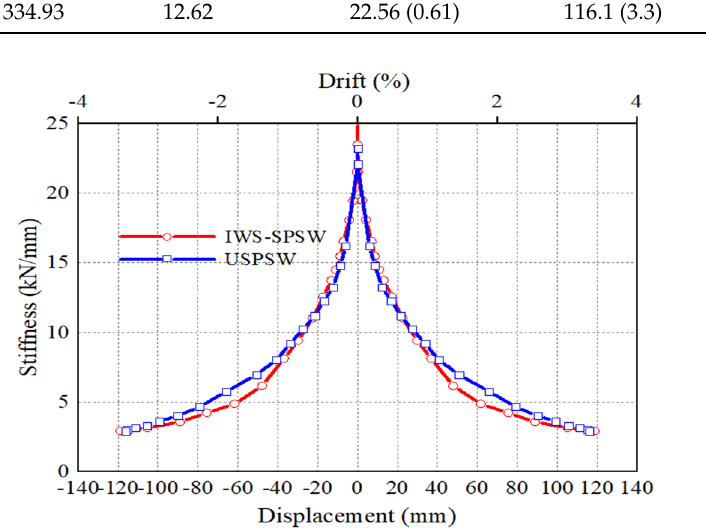
Figure 10. Stiffness degradation.